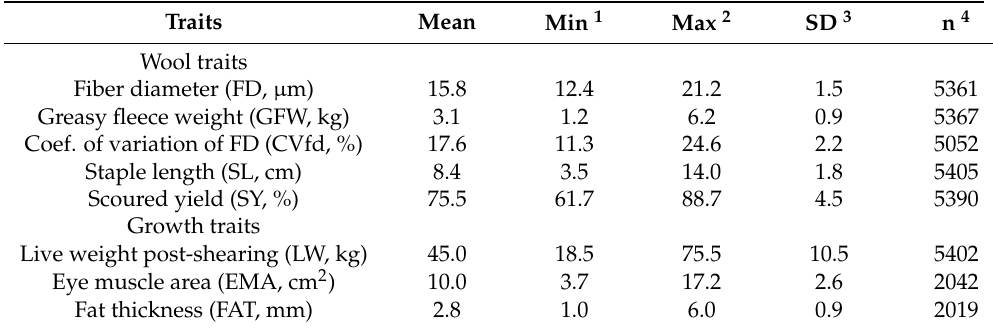
Table 3. Descriptive statistics for the combined one-year-old female and male wool and growth traits